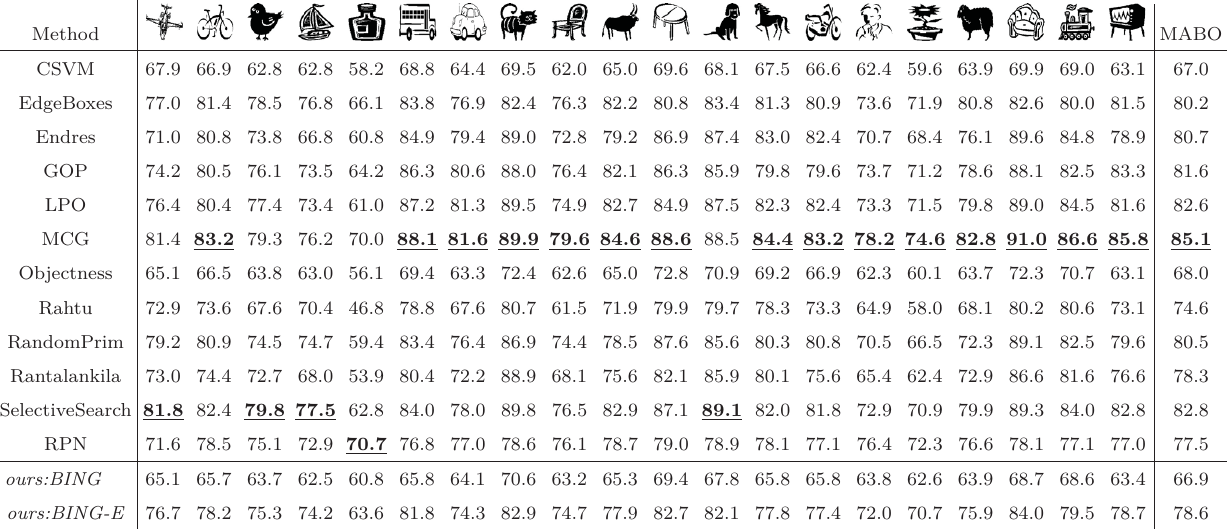
Table 4 ABO & MABO (%) using at most 1000 proposals per image on the VOC2007 test set